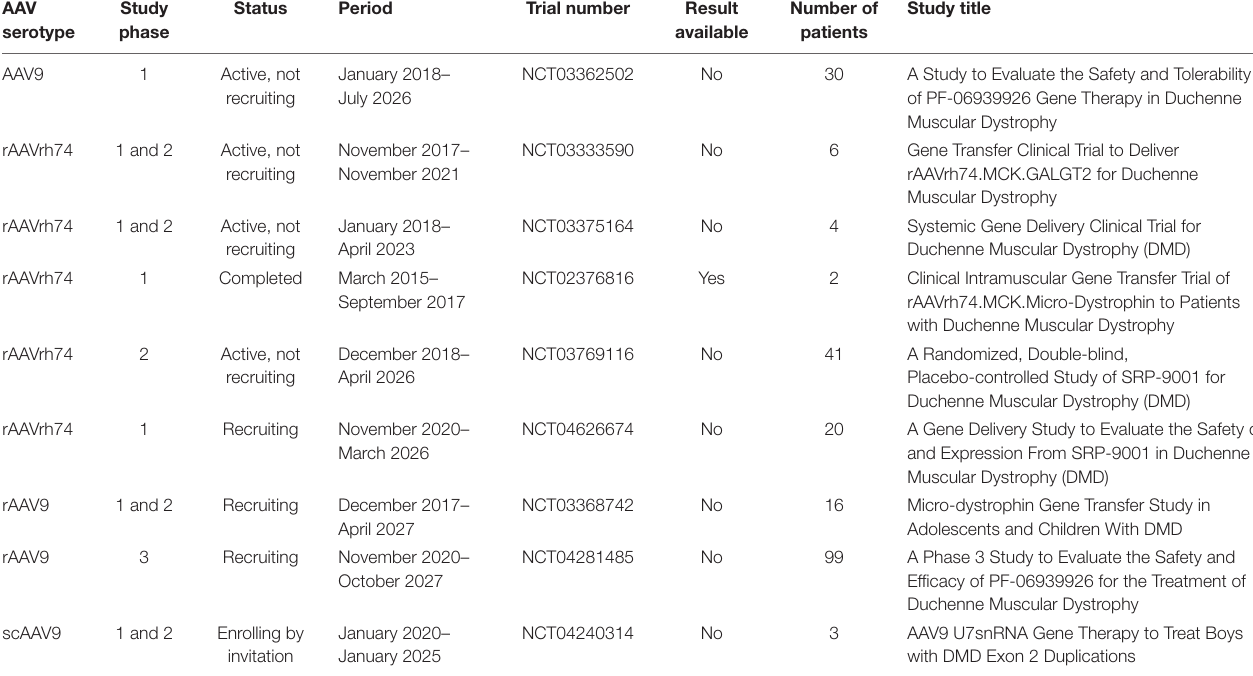
TABLE 2 | Summary of clinical trials of gene transfer for